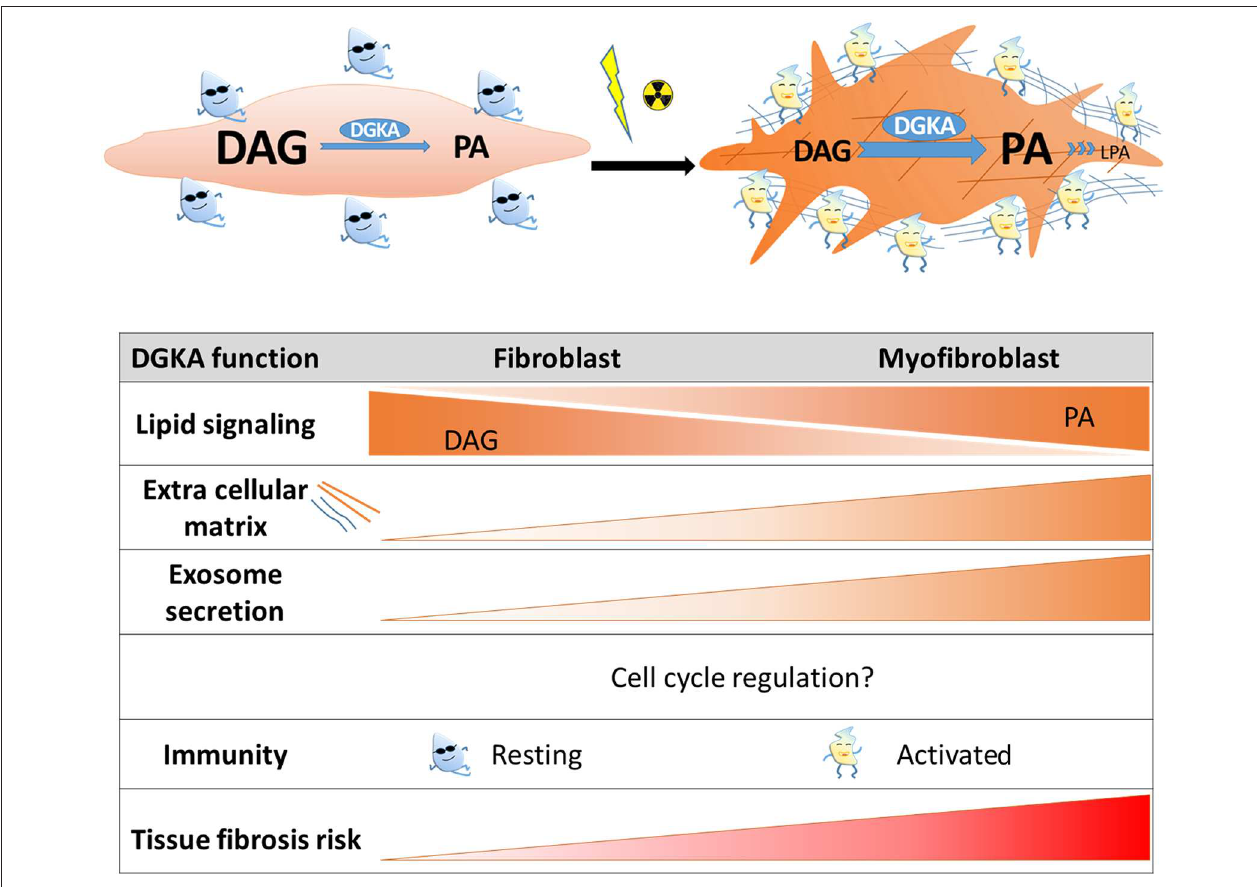
FIGURE 1 | Scheme of DGKA functions contributing to radiation-induced fibrosis. Induction of DGKA by ionizing irradiation or other extracellular stimuli activates several functions in cells like DAG to PA conversion, lipid signaling, exosome secretion, and production of extracellular matrix proteins. According to cell type, these functions might regulate trans-differentiation to myofibroblasts, activation of immune cells, or pro-fibrotic processes. Interaction of these activated cell types is required for tissue regeneration after irradiation, however, persistence of activated cell states and increased extracellular matrix production will contribute to